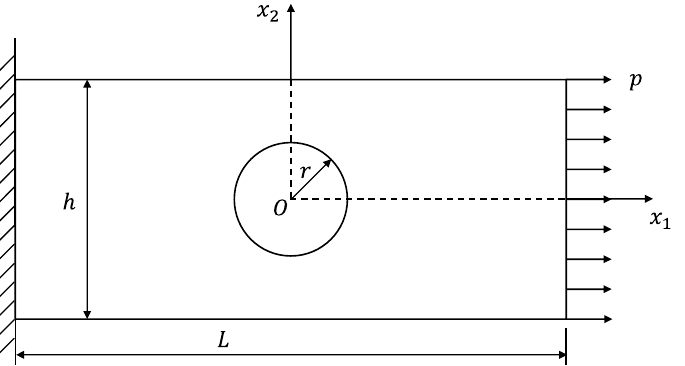
Figure 13. Rectangular plate with a central hole under a distributed traction.